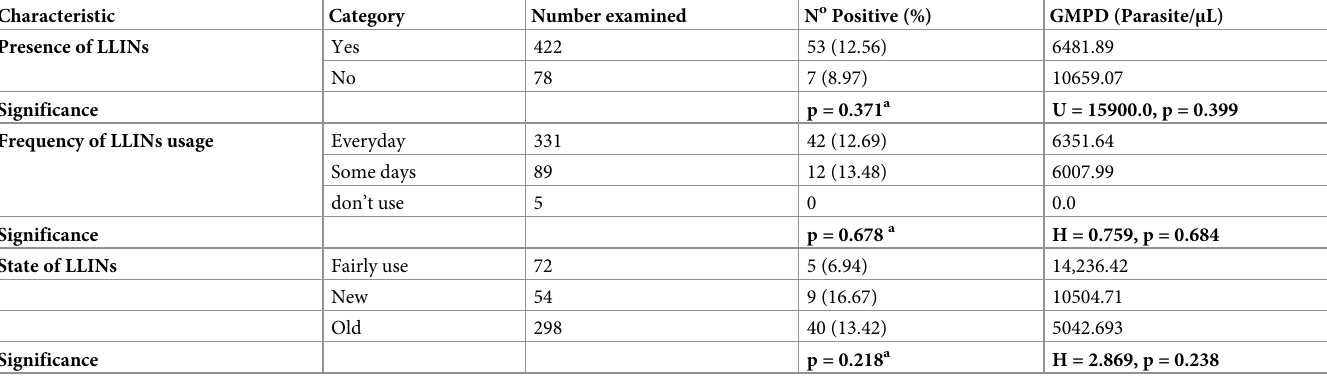
Table 6. Prevalence and parasite density of malaria with respect to utilization of